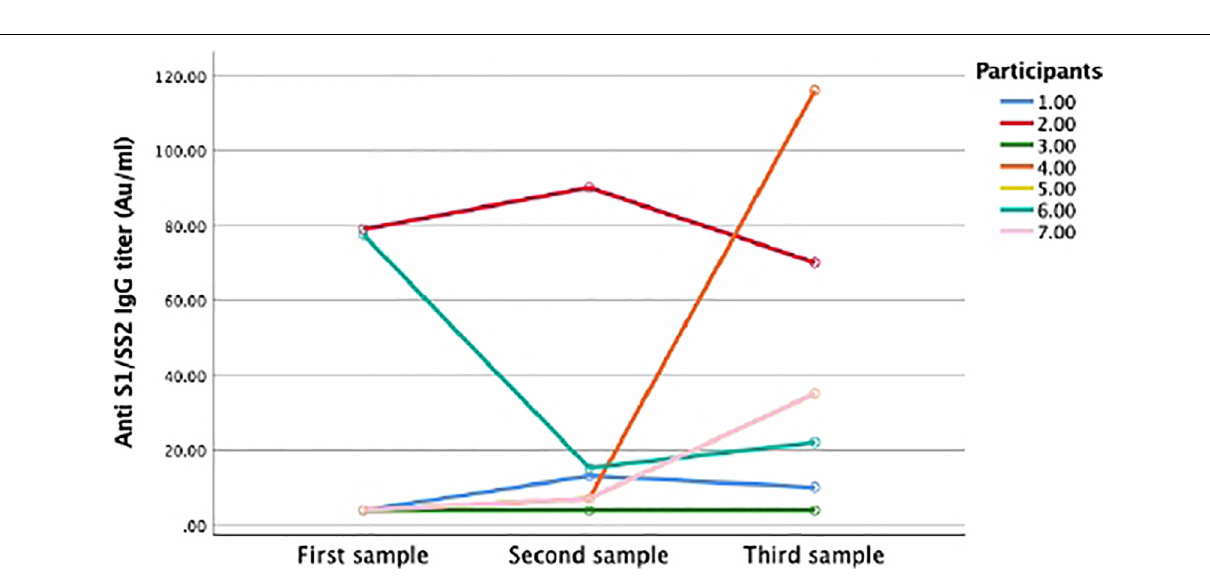
FIGURE 5 | Anti S1/S2 IgC dynamics for participants with three repeated samples. Line graph showing the dynamics of anti S1/S2 IgG overtime. Seven participants had three repeated samples overtime. Each line represents one participants. Five participants tested positive in the third sample (2, 3, 4, 5, and 7). One participant lost his antibodies (1) and one did not seroconvert in all samples (6).